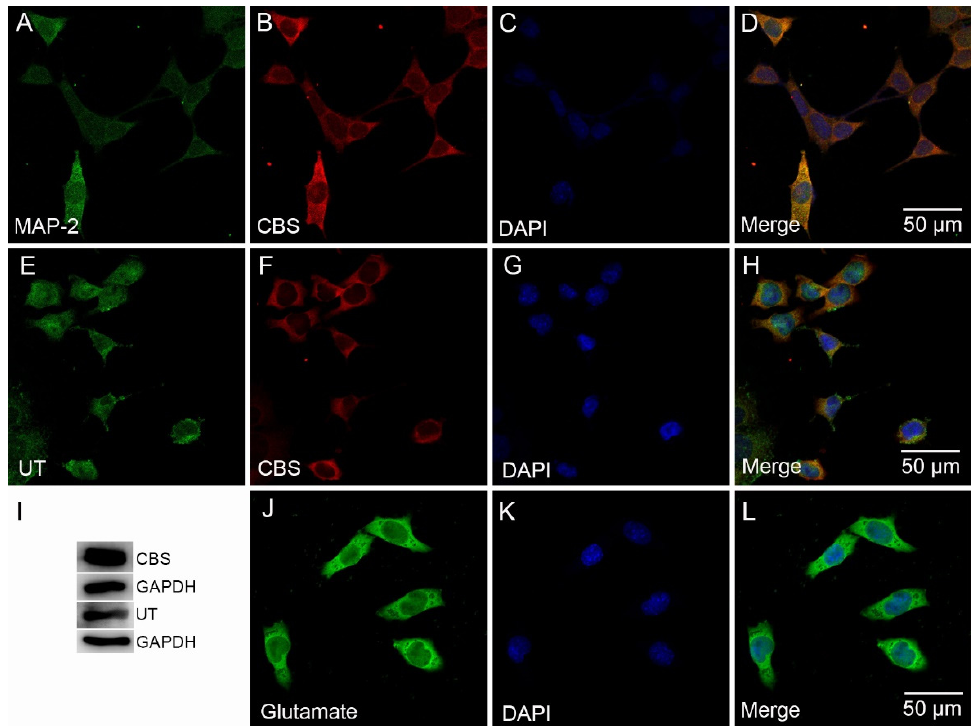
Figure 2. CBS and UT expression in SH-SY5Y cells. Fluorescence micrograph of cells stained with anti-MAP-2 antibody (showed in green, ( A )) and anti-CBS antibody (showed in red, ( B )). Fluorescence micrograph of cells stained with anti-UT antibody (showed in green, ( E )) and anti-CBS antibody (showed in red, ( F )). CBS expressed in the cytoplasm, and UT is mainly expressed in the cell membrane. All nuclei are stained with DAPI ( C , G ). Figure ( D , H ) represent the overlay image. Western blots analysis showed UT and CBS expression ( I ). Confocal images showed a fluorescence